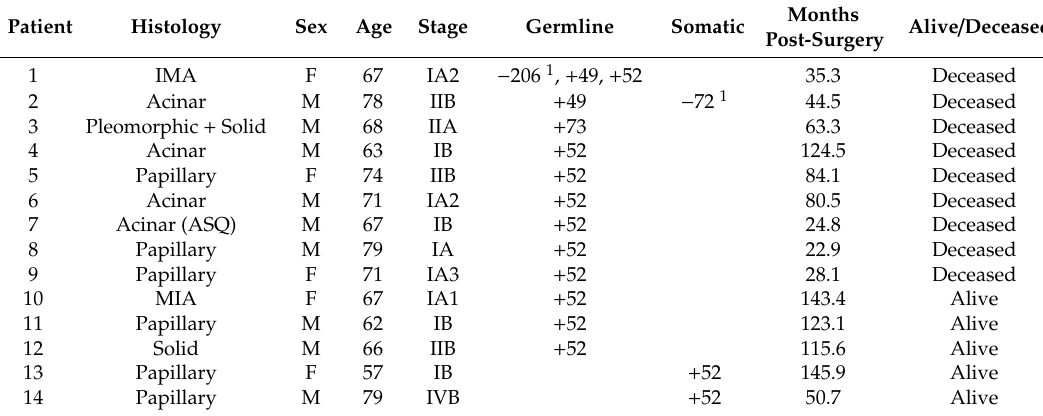
Figure 3. Representative case with a germline single-nucleotide variant (SNV) in the rDNA promoter (case 1). ( A ) Electropherograms of germline SNVs +49C>T and +52A>G from corresponding cancer (upper panel) and normal (lower panel) tissue samples. ( B ) Representative histopathological images of this case (H&E stain) showing invasive mucinous carcinoma accompanied with papillary structure, and ( C ) nuclear pleomorphism and frequent mitoses. Scale bar, 50 µ m. Table 3. rDNA promoter SNVs (at positions + 1 to + 100) found in lung adenocarcinoma